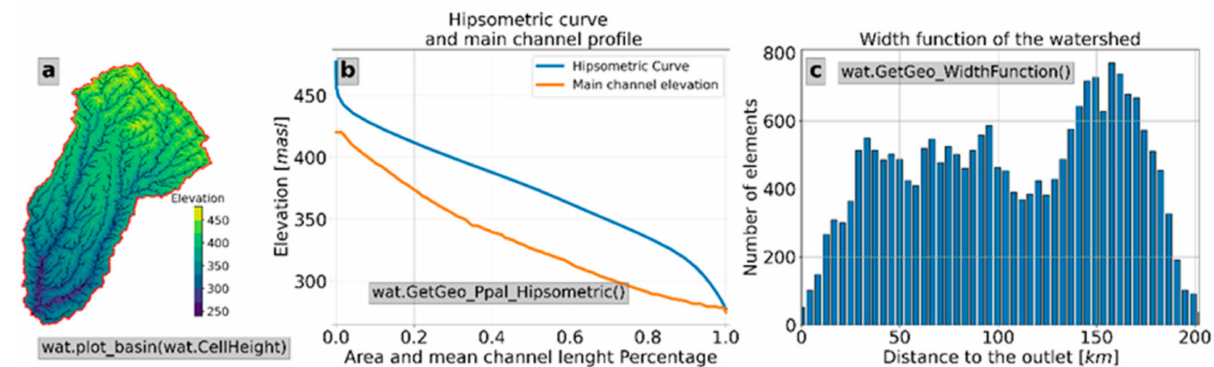
Figure 6. Example of some geomorphological properties obtained with WMF. Each panel presents a feature of the watershed and its corresponding function. Panel ( a ) shows the watershed, elevation, and streamflow network; panel ( b ) shows the hypsometric and the main channel profile, and panel ( c ) shows the width